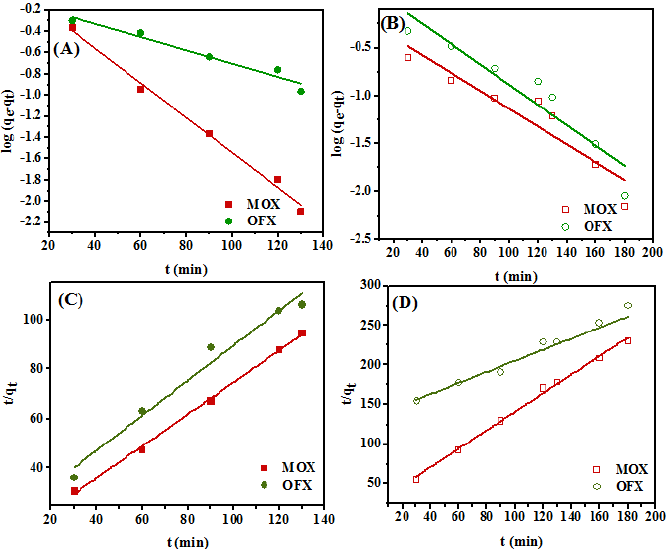
Figure 12. Pseudo-first order and pseudo-second order kinetic models for adsorption of MOX and OFX onto ( A , C ) Met-GO/SA as adsorbent (adsorption conditions: concentration = 20 mg/L; temperature = 35 °C; adsorbent dosage = 0.25 g, pH = 7) and ( B , D ) GO/SA as adsorbent (adsorption conditions: concentration = 20 mg/L; temperature = 35 °C; adsorbent dosage = 0.4 g, pH = 7), respectively.